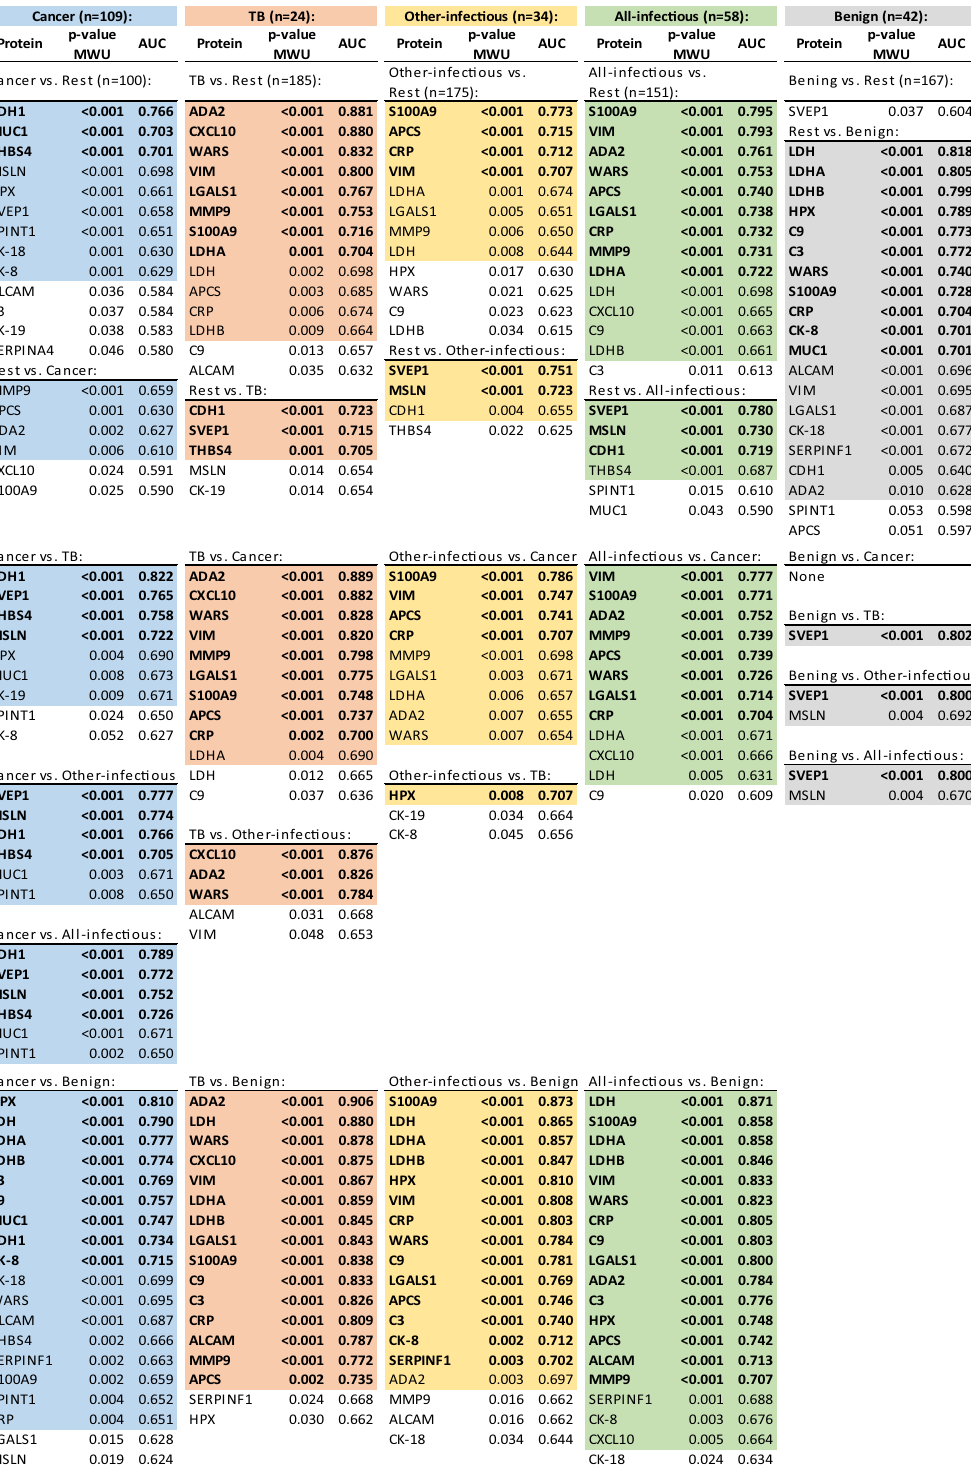
Table 2. Protein markers significantly different between the five PE types, and their potential diagnostic utility. Shown in order of significance for all possible 26 comparisons as indicated by the AUC value from ROC curve analysis. All significant differences in marker amount with a p-value ≤ 0.05 (MWU test) are shown to enable a comparison of most markers, while those that performed best are highlighted (p-value ≤ 0.01 MWU test (colored), and AUC: ≥ 0.700 (bold)). For a detailed table including AUC 95% confidence intervals, significance values, and peptides used in the calculations see Supplementary Table